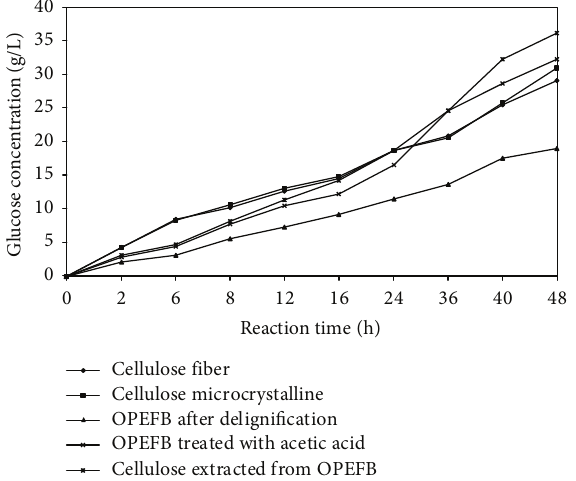
Figure 4: Effect of pre-treatments on enzymatic hydrolysis of various cellulose substrates.